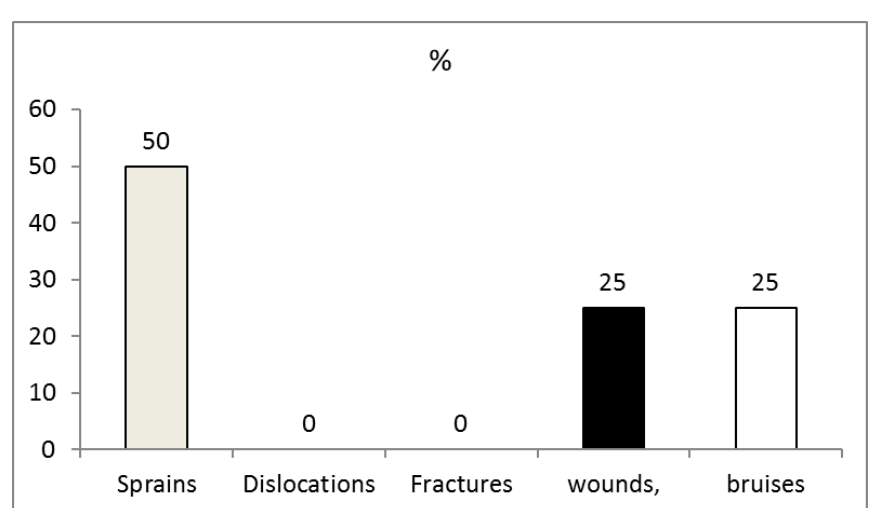
Figure 7. The percentage of injury depending on the type of injury